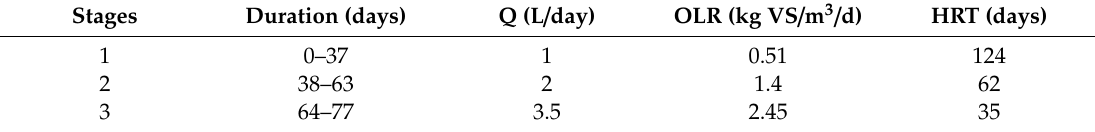
Table 3. Operational conditions of semi-continuous single-stage anaerobic digestion